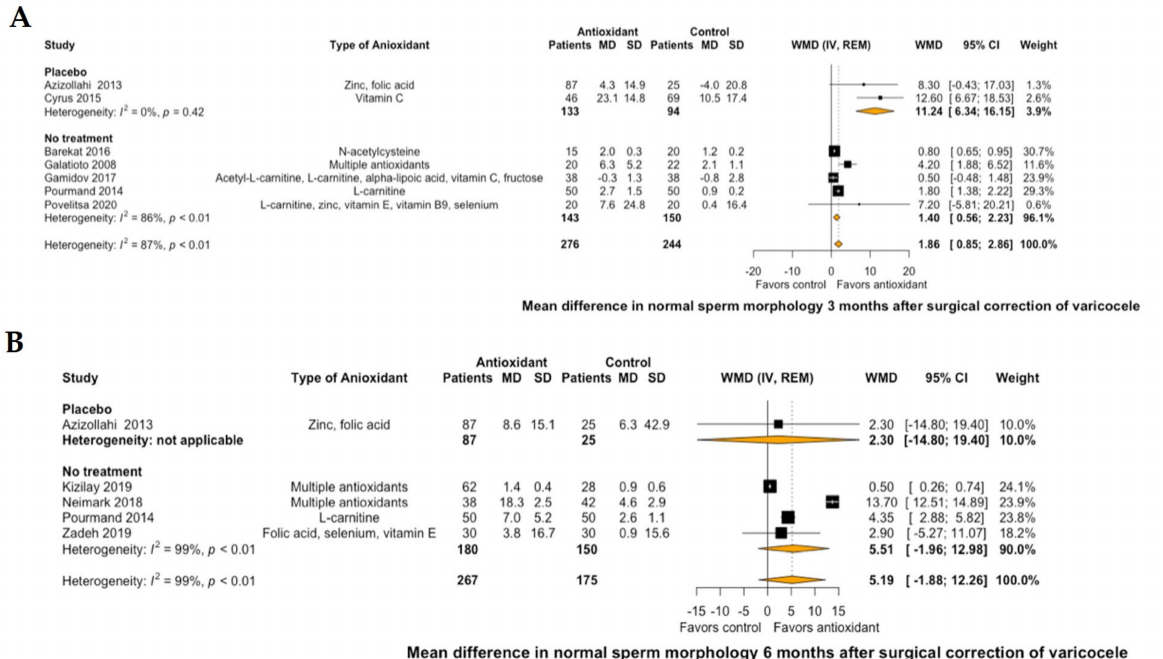
Figure 4. Forest plot of mean difference in normal sperm morphology at 3 months ( A ) and 6 months ( B ) after treatment with antioxidants versus placebo or no treatment in patients with surgical correction of varicocele. CI: confidence interval; IV: inverse variance; MD: mean difference; REM: random effects model; SD: standard deviation; WMD: weighted mean